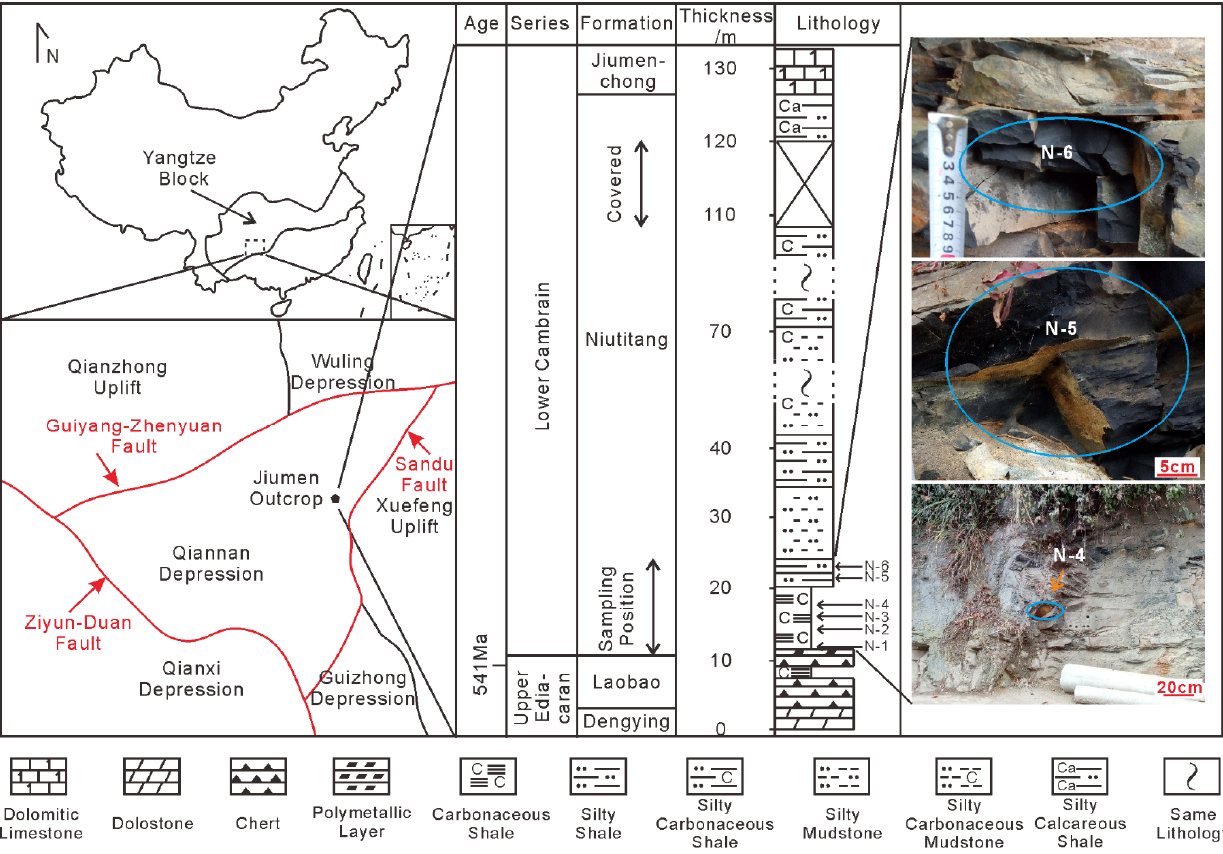
Figure 1. Outcrop position and lithology, modified after [31].